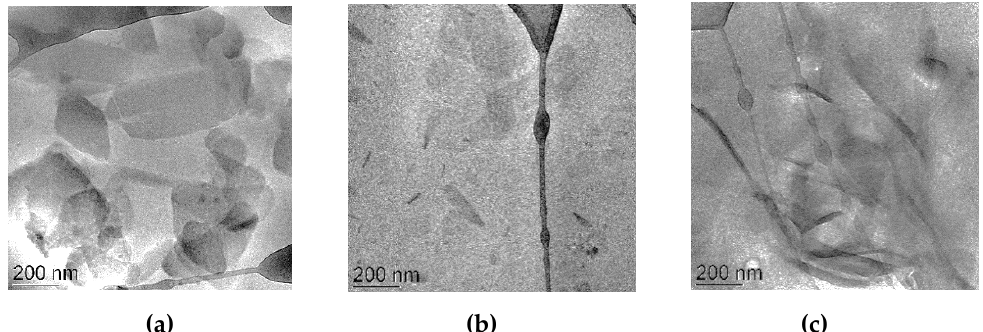
Figure 1. Cryogenic Transmission Electron Microscopy (Cryo-TEM) images of drug loaded solid lipid nanoparticles (SLN-CA) ( a ) and of SLN-P-CA ( b , c ).